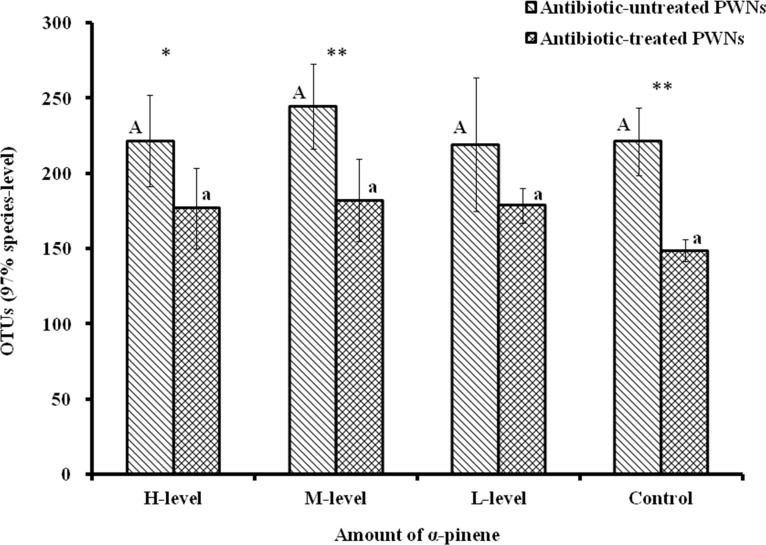
OTUs of bacteria.Different letters indicate significant (p < 0.05) differences in OTUs of corresponding nematode groups, as detected by Tukey's HSD test. Dots represent differences between two nematode groups (*p < 0.05, ** p < 0.01).